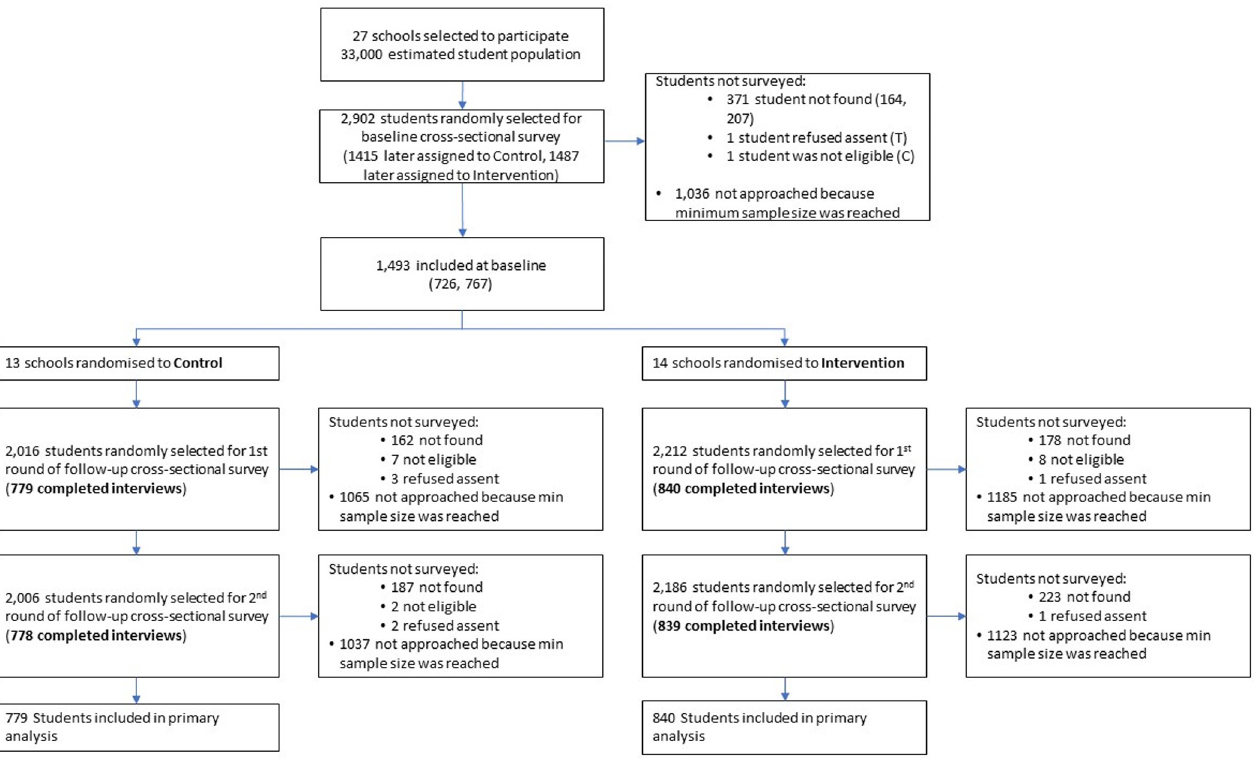
Fig 1. Trial flow diagram. At each round of data collection, a back-up sample of students was randomly generated following the same procedure as for the main target sample. Whenever a randomly selected respondent was not found, not available, not eligible, or refused consent, enumerators were instructed to select a replacement student from the list of back-ups. Enumerators were instructed to stop replacements when the minimum (min) sample size per school was reached. This strategy was adopted because the lists of all students enrolled were of low quality and poorly maintained; therefore, high volumes of missing students were expected. First round of follow-up cross-sectional survey = midline; second round of follow-up cross-sectional survey = endline. C, control; T, intervention AU : IaddedtextattheendofthelegendforFig 1 equatingtermsbetweenFig 1 andthemaintext ; anddefiningtwoabbreviationsusedinFig 1 : Pleasecheckthattheseeditsarecorrect ; especiallythatT ¼ intervention :